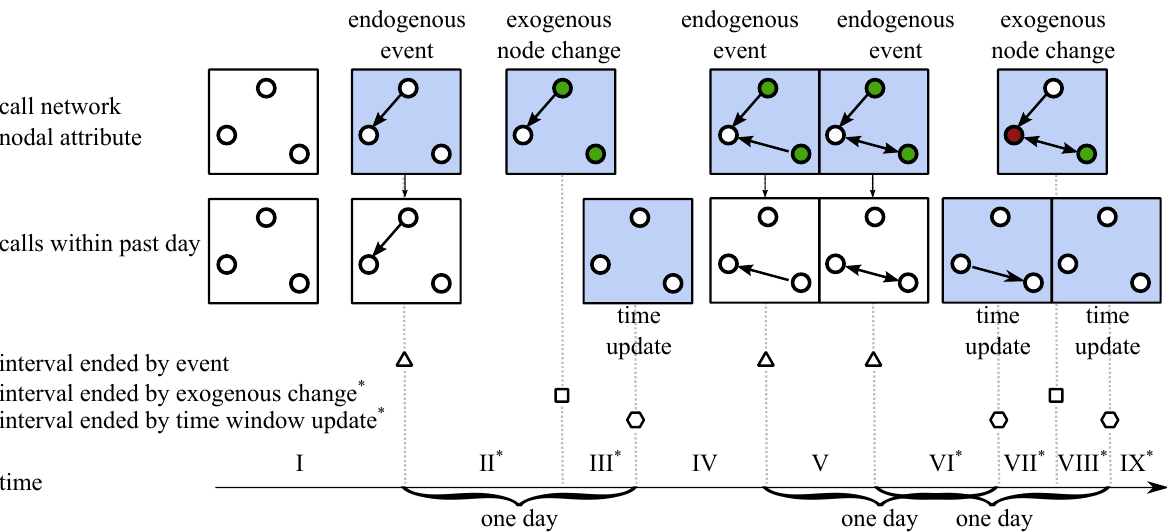
Figure 2: An exemplary process of call events that changes because of an endogenous process (call events change two network representations), a time window–related process (a network represents all phone calls that were made within the past day), and an exogenous process (update of a nodal attribute). The process state elements are shown in squares. Intervals that end because of exogenous changes or because of the update of time window representations (right-censored intervals) are marked with an